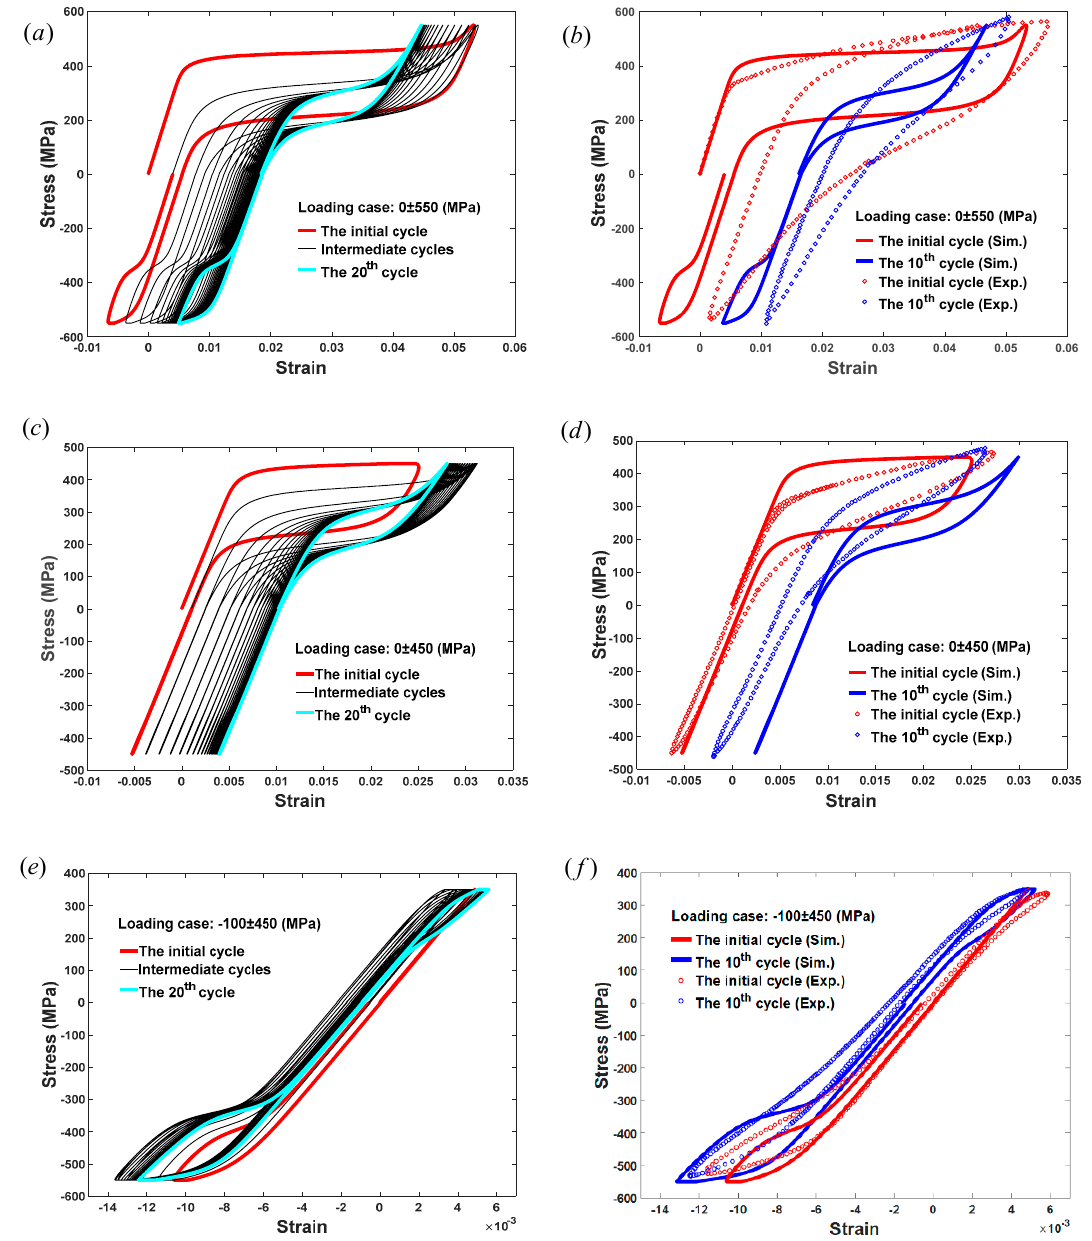
Figure 4. Model predictions and experimental verifications of the proposed constitutive model used for pseudo-elastic SMAs. ( a ) Model prediction under loading with stress range of 0 ± 550 MPa; ( b ) Experimental verification under loading with stress range of 0 ± 550 MPa; ( c ) Model prediction under loading with stress range of 0 ± 450 MPa; ( d ) Experimental verification under loading with stress range of 0 ± 450 MPa; ( e ) Model prediction under loading with stress range of − 100 ± 450 MPa; ( f ) Experimental verification under loading with stress range of − 100 ± 450MPa. (“Sim.” represents the simulation results and “Exp.” represents the experimental results).